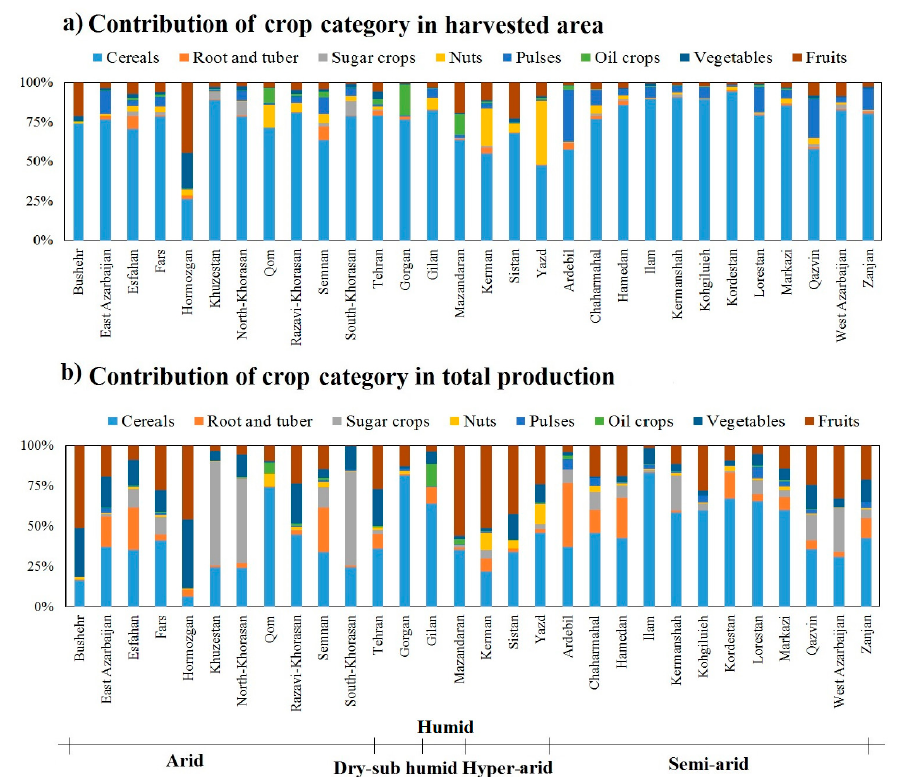
Figure 3. The 30-year average contribution of different crop categories to total harvested area (HA) per province ( a ) and total crop production (CP) per province ( b ). Period 1980–2010.